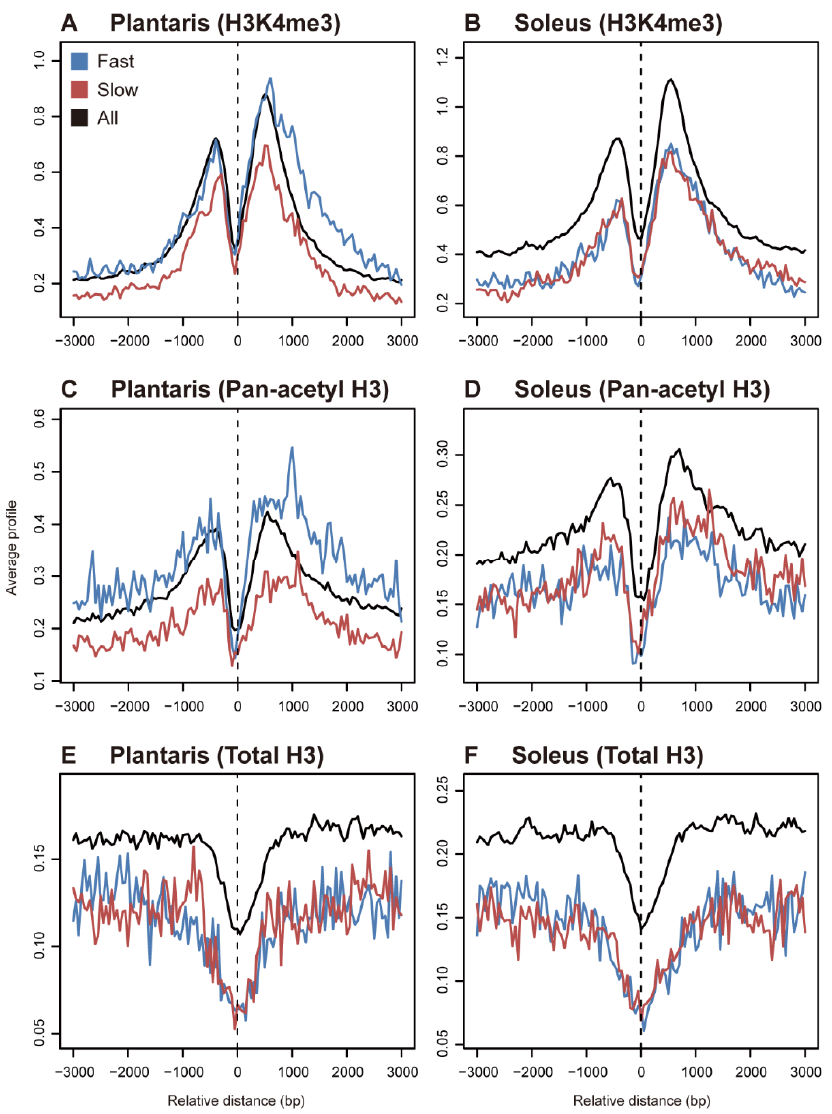
Figure 1. Different histone modifications in fast- and slow-twitch-specific genes of rat plantaris and soleus muscles. Distributions of transcriptionally active histone modifications, H3K4me3 ( A , B ), H3 acetylation ( C , D ), and total H3 ( E , F ) near the transcription start site (0 position) in the plantaris ( A , C , E ), and soleus ( B , D , F ) muscles were analyzed using ChIP followed by next generation sequencing. The distributions were averaged in fast-twitch-specific (blue), slow-twitch-specific (red), or all (black) genes. ( A – D ) were reproduced from Kawano et al. [21]. ( E , F ) were obtained from additional analysis of the results using the samples obtained from Kawano et al.